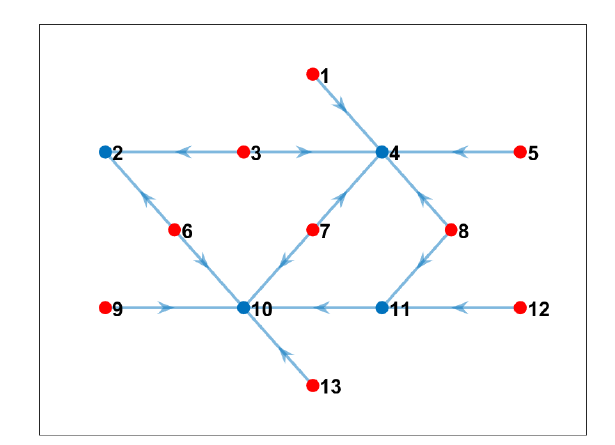
Figure 8. Communication pattern using the proposed model when we considered unlimited bandwidth (blue nodes are nodes that computed cross-correlation; red nodes only sent data to the corresponding